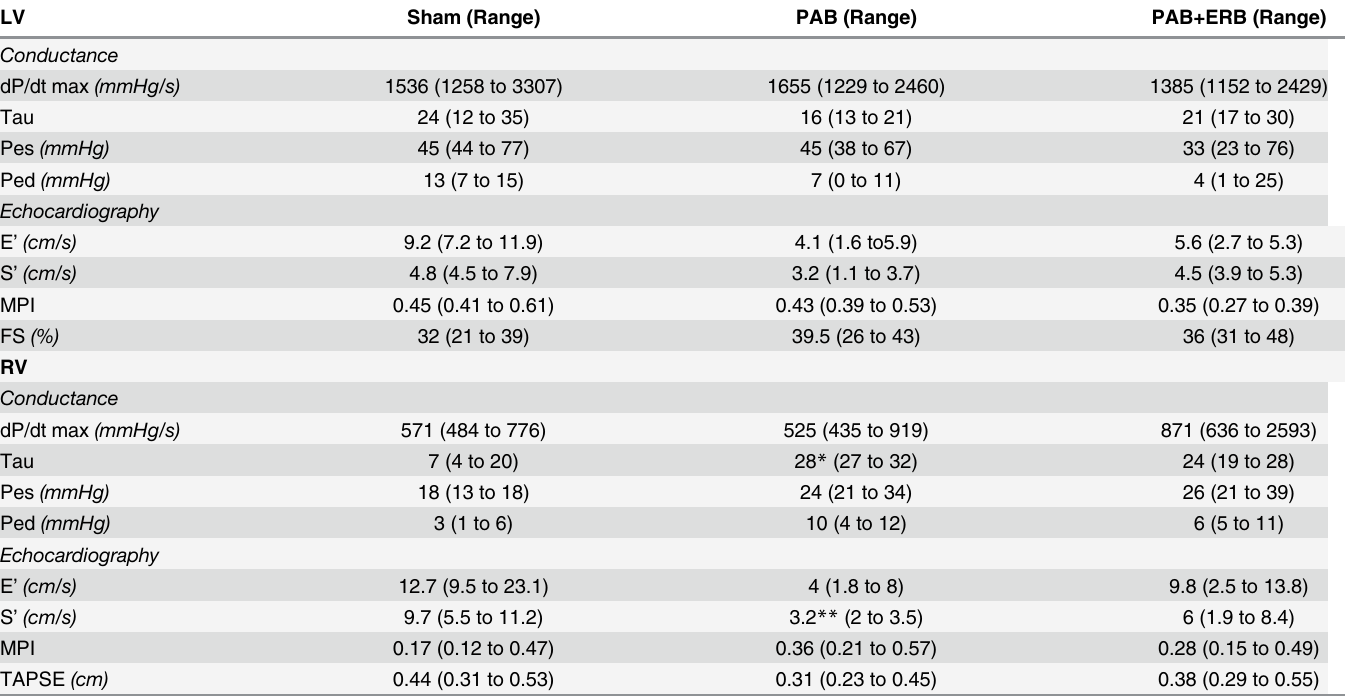
Table 1. Hemodynamic and functional characteristics. Conductance and echocardiographic results presented as median (range) as the data is not nor- mally distributed. Pes: end-systolic pressure, Ped: end-diastolic pressure. Sham (n = 3), PAB (n = 5), and PAB+ERB (n = 5). The groups were compared using Kruskal-Wallis multiple comparisons. Post hoc test